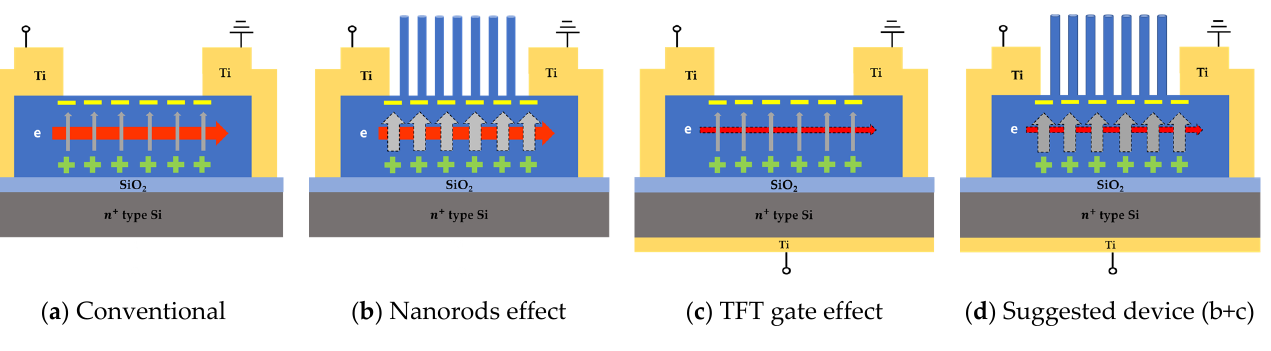
Figure 10. Schematic illustration of mobility deterioration sensing mechanism of lateral ZnO piezotronic pressure sensors. The dot outline indicates the changed component due to the effect; ( a ) Conventional thin film ZnO pressure sensor; ( b ) Nanorods effect. The vertical E-field is enlarged due to the amplified pressure; ( c ) TFT gate effect. The lateral current flow in the channel is intentionally weakened by the gate voltage; ( d ) Suggested device. Both NRs effect and TFT gate effect can be used to achieve improved sensitivity and reduced power consumption. Table 5. TFT parameter extraction .